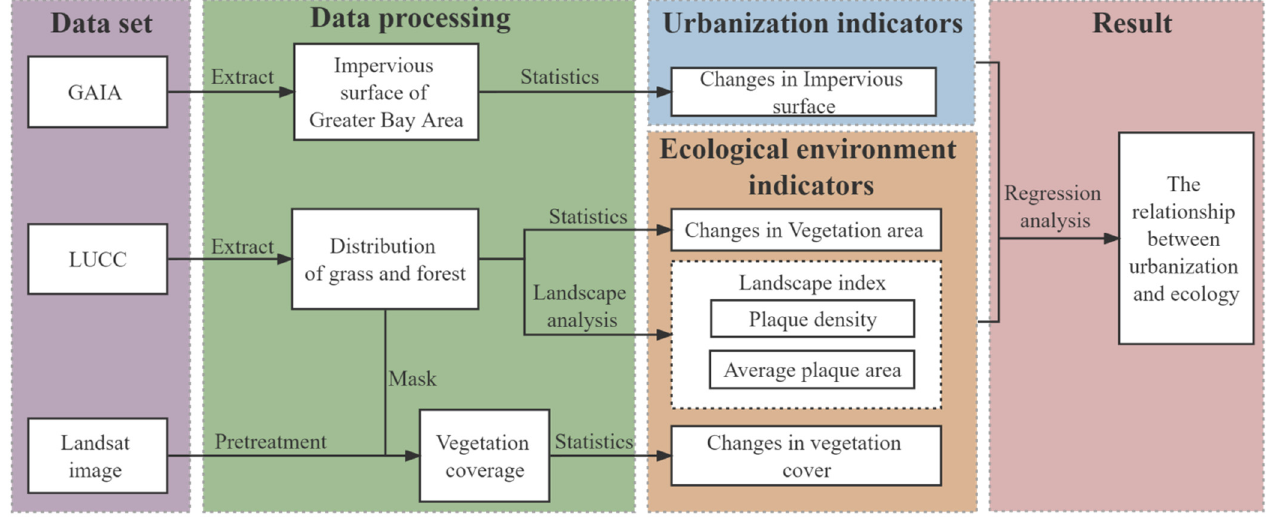
Figure 4. The workflow of this